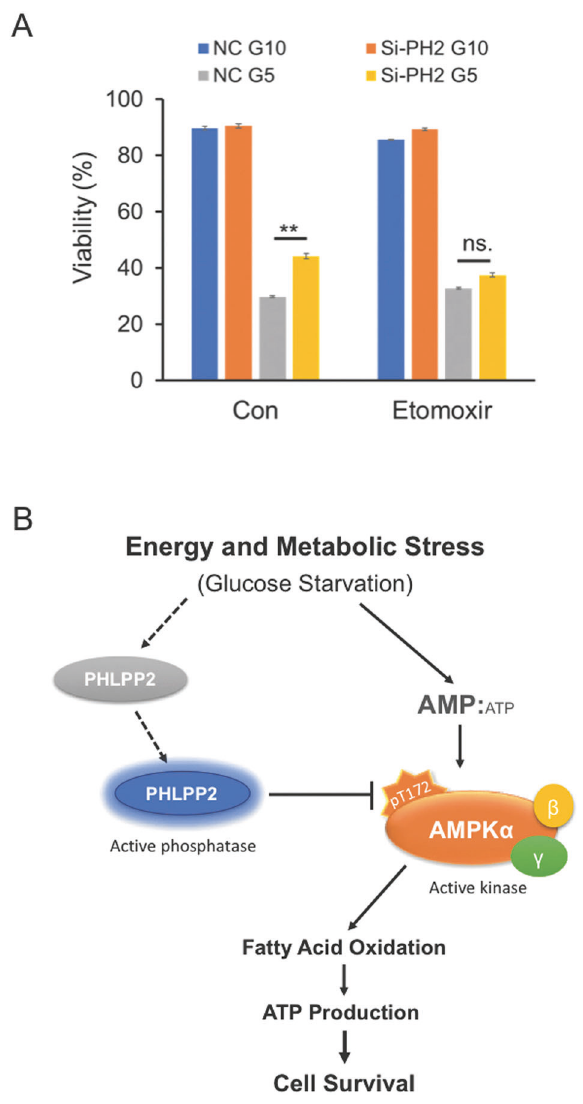
Fig. 6 PHLPP2 regulation of the cellular response to metabolic stress is mediated by AMPK and fatty acid oxidation. A Pro-survival effects of PHLPP2 knockdown were reversed by FAO inhibition. Control siRNA (NC) or PHLPP2 siRNA (Si-PH2) transfected Jurkat cells, were cultured for 4 days (24 h post-transfection) in a medium containing either 10 mM or 5 mM glucose, in the presence or absence of 20 μ M Eto, and analyzed for cell viability by fl ow cytometry. Two- way ANOVA analysis was used to compare experimental groups. B A simple model to illustrate how PHLPP2 functions as a tumor suppressor in cells undergoing metabolic stress. Under conditions of limited glucose availability, when AMP:ATP ratios are high, energy- sensing kinase AMPK is activated by phosphorylation and promotes fatty acid β -oxidation (FAO), enabling cells to generate energy and survive. Dephosphorylation of p-AMPK α at T 172 by PHLPP2 inactivates the kinase and, subsequently, FAO, leading to cell